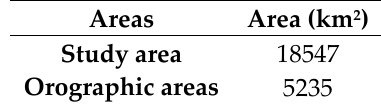
Table 1 . Extent of the study area and of the orographic areas (4th and 3rd